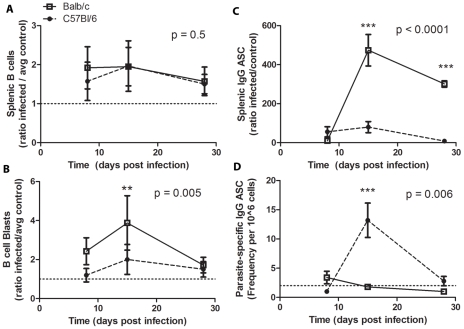
Splenic B cell expansion with or without parasite specific ASC.
A, Splenocytes were stained and analyzed by flow cytometry for enumeration of B cells. B, B cells were analyzed by forward and side scatter for blast formation. These plots show the total splenic B cells in infected mice compared to the total number of splenic B cells in control mice of the same genotype. C, B cell ELISPOT analysis was completed to enumerate total IgG ASC from spleens of infected and control mice (n = 5 mice per group per time-point). The results are presented as the ratio of infected to average control of the same genotype. D, B cell ELISPOT analysis was used to enumerate the frequency of CRP-specific IgG ASC in the spleen of infected mice (n = 5 mice per group per time-point). Balb/c are represented by open squares, solid line; C57Bl/6 mice by closed circles, dashed line. ** p<0.01, *** p<0.001 by Bonferroni post-test after 2-Way ANOVA comparing Balb/c and C57Bl/6 models (p values reported on graphs).